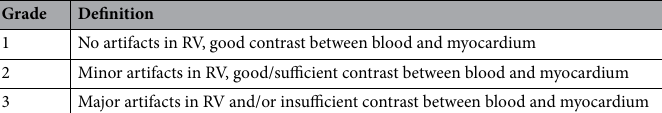
Table 1. Grading of image quality for evaluation of right ventricular regions of interest. RV = right